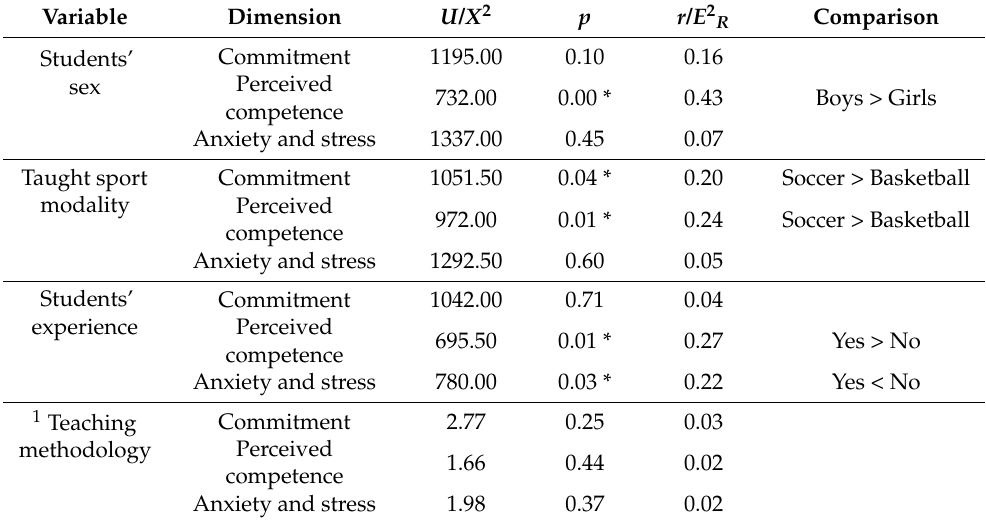
Table 3. Differences between the categories of each of the independent variables by dimension. Variable